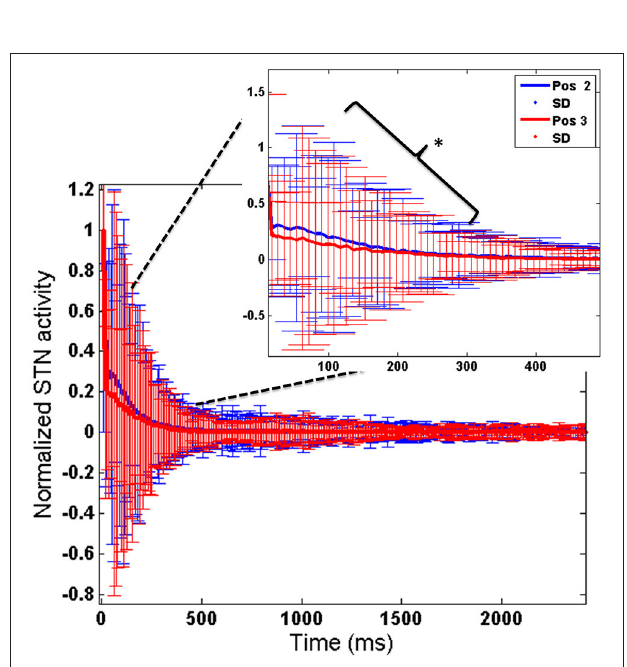
FIGURE 11 | Shows the STN activity for HC conditions for 2 electrode positions (Pos 2 and Pos 3). X-axis shows the simulation time and Y-axis shows the normalized STN activity with SD across time. The inset picture clearly shows a significant reduction in STN activity for Pos 3 of DBS electrode. *Indicates the significance level at p <